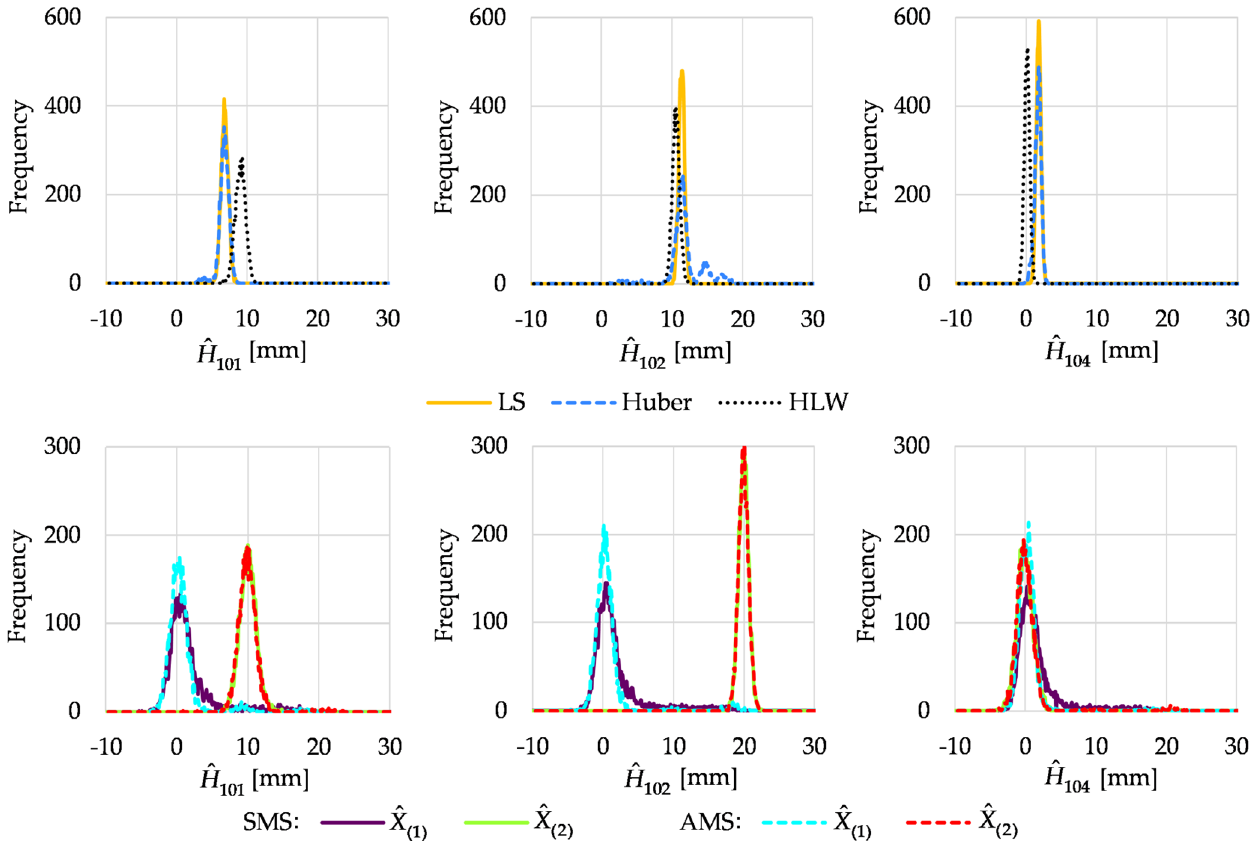
Figure 3. Histograms of estimated point heights in Variant II.